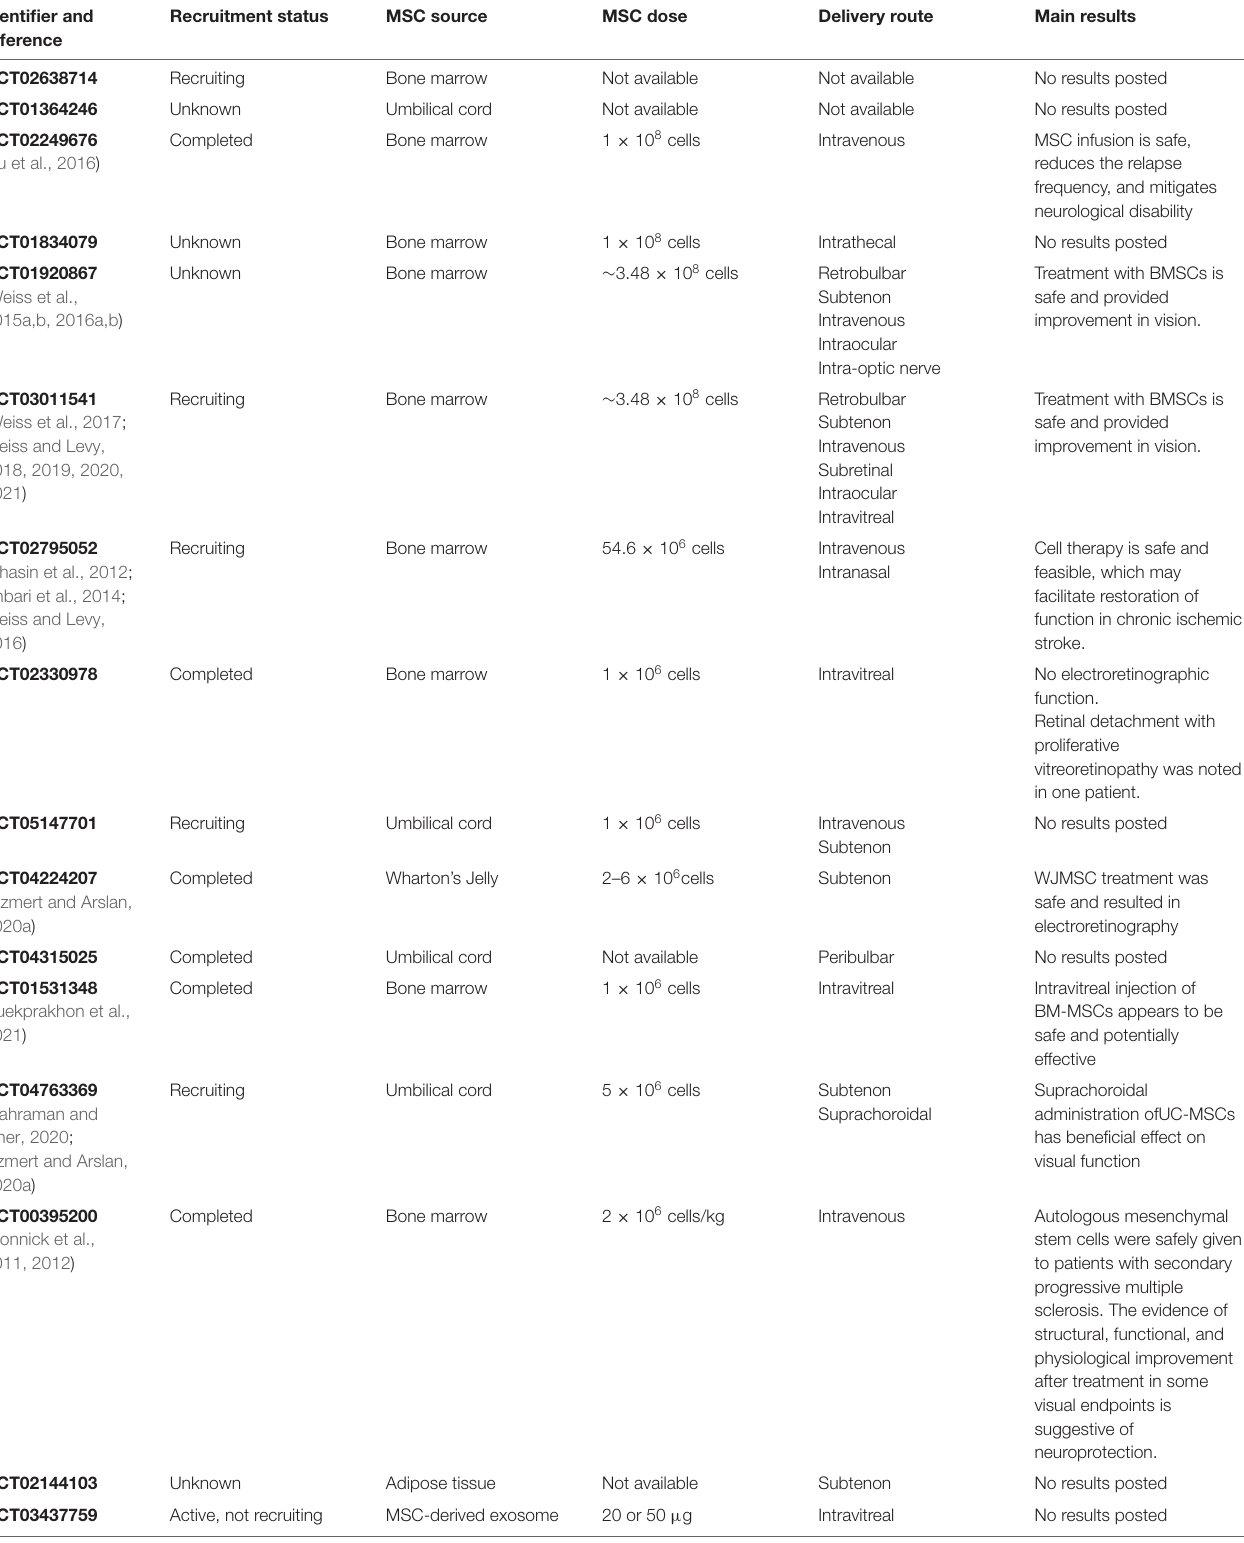
TABLE 2 | Clinical trials using mesenchymal stem/stromal cells in retinal